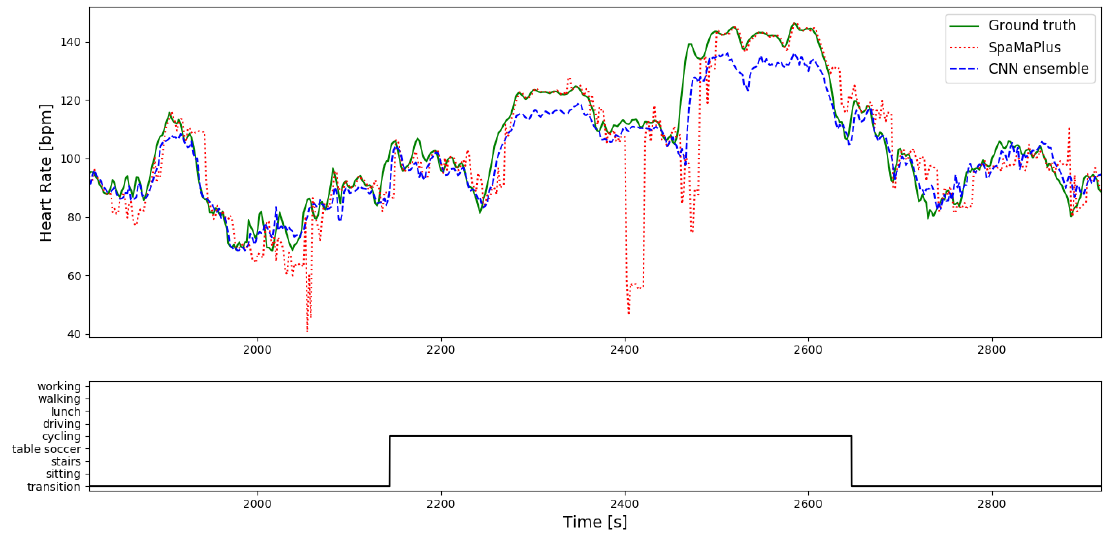
Figure 8. Heart rate estimation on the cycling part of session S7 of the dataset PPG-DaLiA : Ground truth vs. prediction based on the SpaMaPlus approach vs. prediction based on our deep learning model (CNN ensemble). Activity labels are displayed in the lower subplot of the figure.